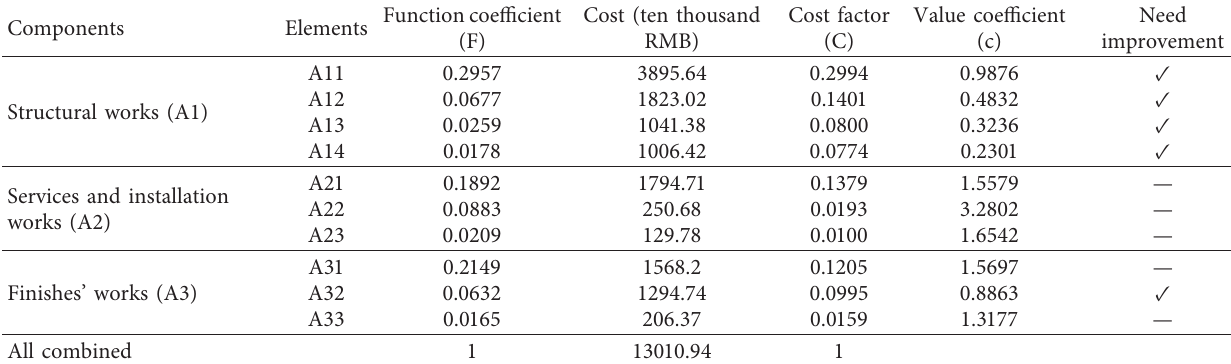
Table 10: Value coefficient calculation table of the CJ building construction project.